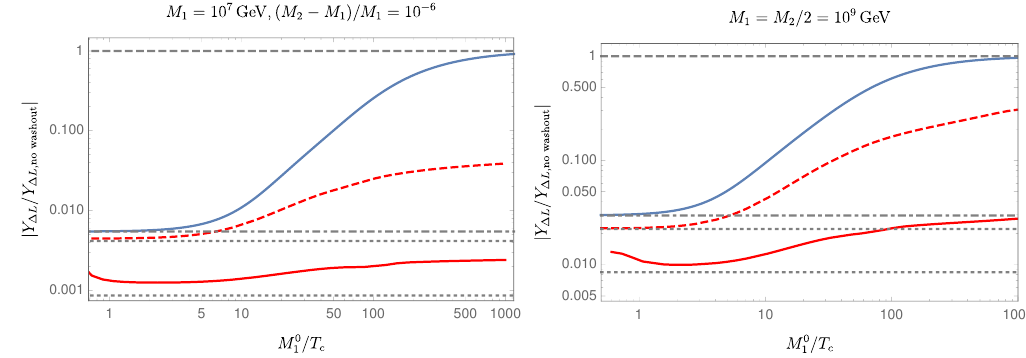
Figure 6 . Ratio of the total lepton asymmetry vs. its value in the zero washout limit, plotted as a function of M 0 =T c , for two (cid:13)avours of N I and three (cid:13)avours of L (cid:11) . For the left pane, M 1 = 10 7 GeV, 1 ( M 2 (cid:0) M 1 ) =M 1 = 10 (cid:0) 6 , while on the right pane M 1 = M 2 = 2 = 10 9 GeV. The leptonic Yukawa couplings are compatible with oscillation data. The solid blue lines neglect annihilations, while we include annihilations in the red lines with y 1 = 1 (solid red), and y 1 = 0 : 3 (dashed red). The horizontal lines represent, from top to bottom, the zero washout limit in the absence of annihilations, the constant-mass limit in the absence of annihilations, and then the constant mass limits for y 1 = 0 : 3 and y 1 = 1,